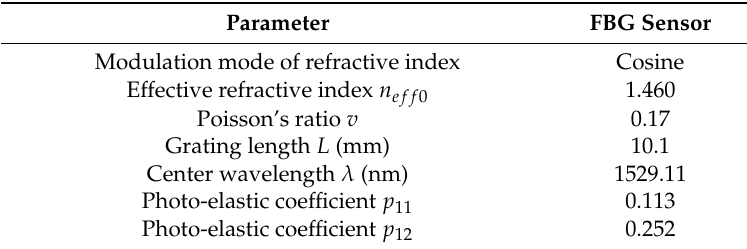
Table 2. Properties of FBG sensors used for fatigue testing.